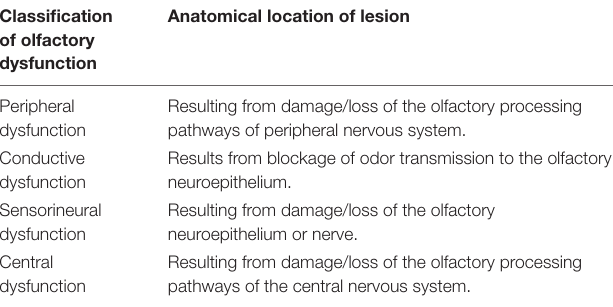
TABLE 1 | Definition of olfactory dysfunction according to anatomical location of lesion. Classification of olfactory dysfunction